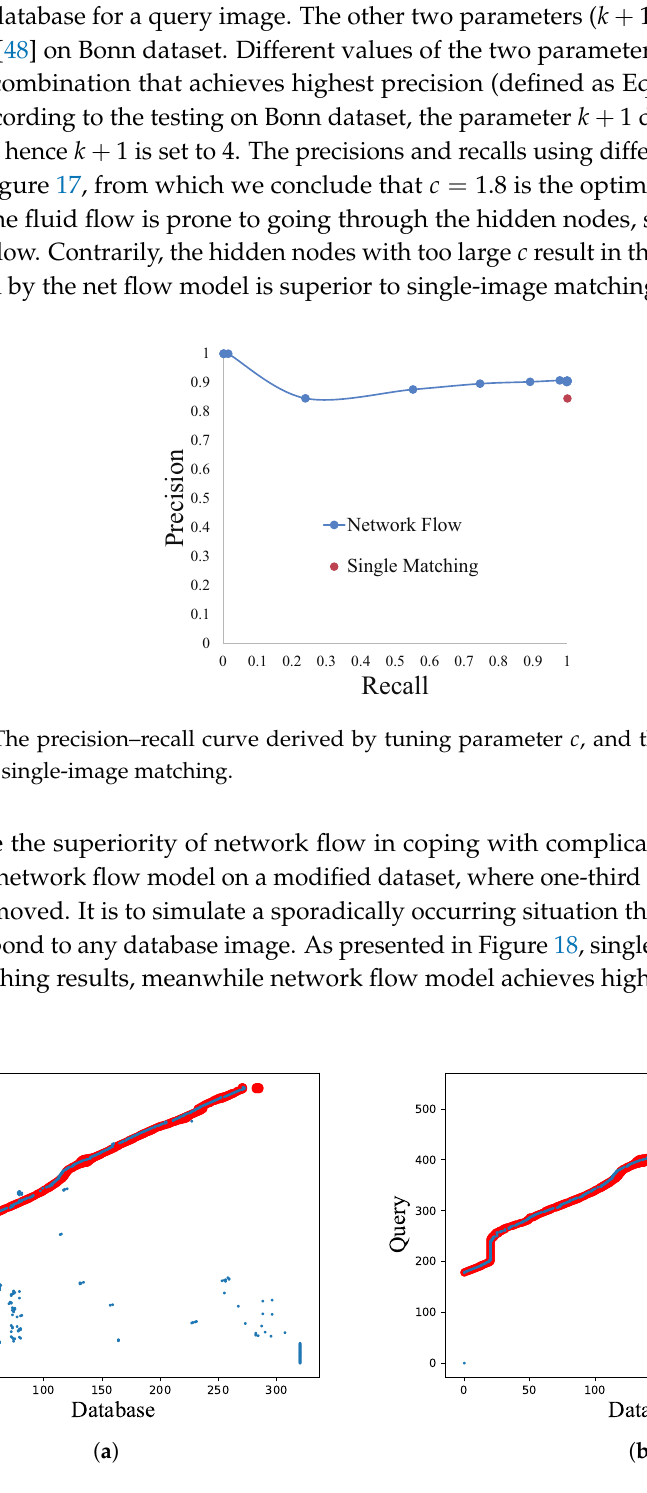
Figure 18. Performance comparison between: ( a ) single image matching; and ( b ) global optimization with network flow on the modified Bonn dataset. The red trajectory denotes the ground truth, and the blue points denote visual localization